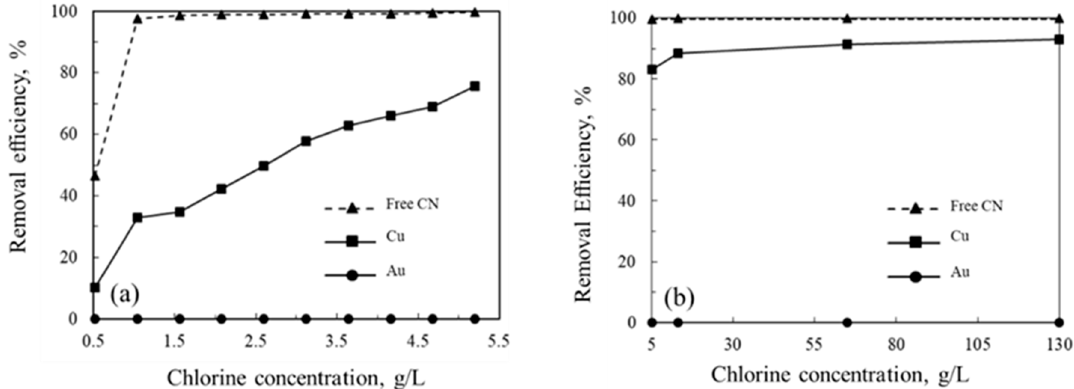
Figure 1. Influence of chlorine concentration on the removal of copper and free cyanide ( a ) using electro-generated NaOCl ( b ) using reagent-grade NaOCl (initial pH, 9.8–13.3; temperature, 298 K; time, 12 h without agitation; total volume, 200 mL with NaOCl / leach solution ratio 1; chlorine concentration 0.52–130 g/L).